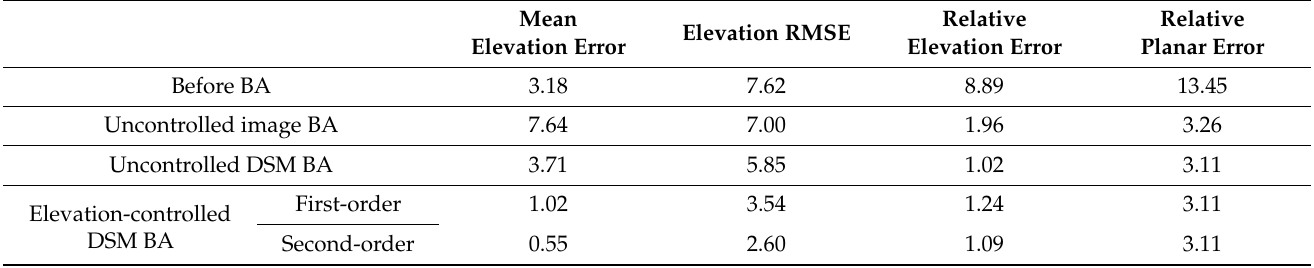
Figure 3. Comparison of ZY-3 DSMs before and after block adjustment in object and image space. ( a ) Original DSMs, ( b ) uncontrolled DSM block adjustment, ( c ) uncontrolled image block adjustment, and ( d ) controlled DSM block adjustment. Table 2. Accuracy of the ZY-3 DSMs before and after block adjustment (BA) (unit: